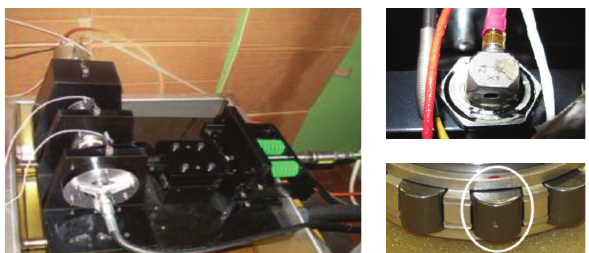
Figure 5: DIRG test rig, the axes orientation of the triaxial accelerometers ( x , y , and z ) and the damaged roller used in the tests.